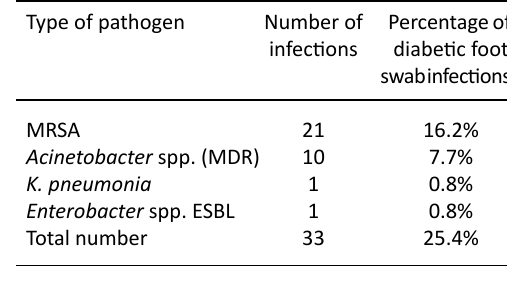
Table 4-B.3. Multidrug-resistant isolates of diabetic foot